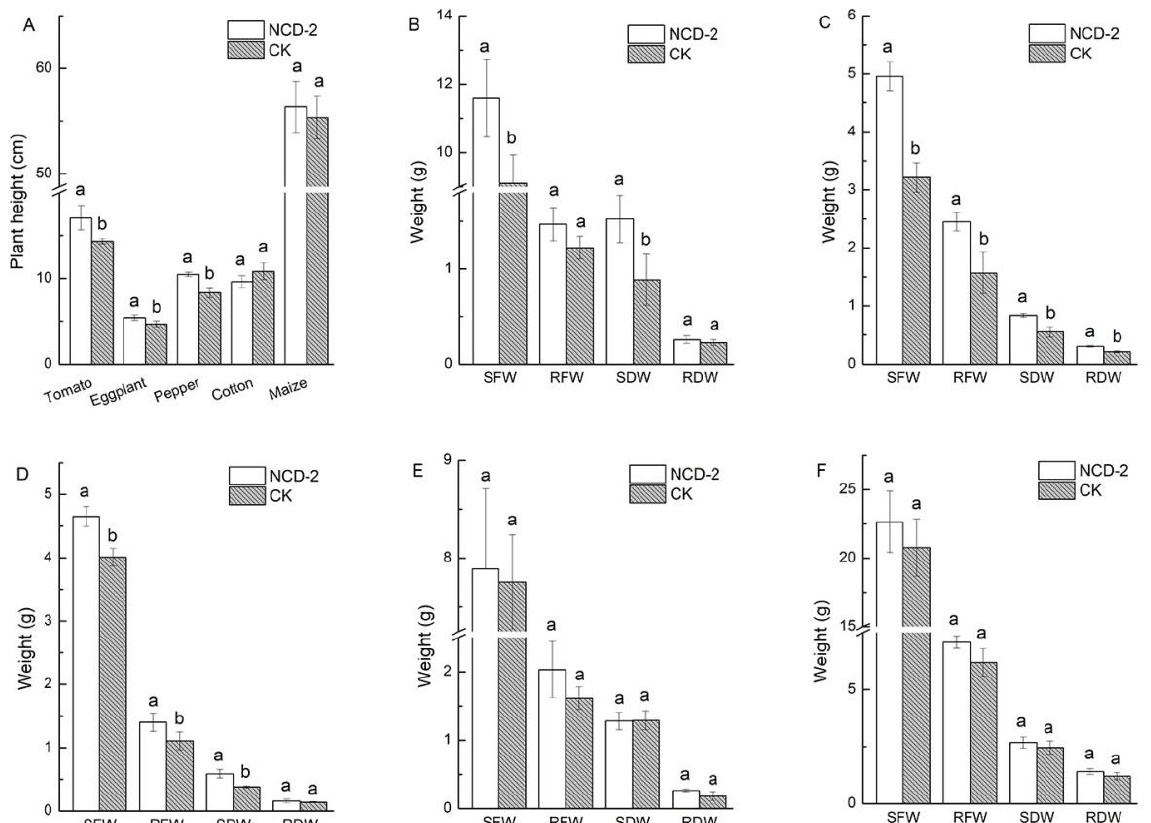
Figure 1. Effect of Bacillus subtilis NCD-2 on the growth indices of different crops. ( A ) Plant height; ( B ) plant fresh and dry weight of tomato; ( C ) plant fresh and dry weight of eggplant; ( D ) plant fresh and dry weight of pepper; ( E ) plant fresh and dry weight of cotton; ( F ) plant fresh and dry weight of maize. SFW represents shoot fresh weight, RFW represents root fresh weight, SDW represents shoot dry weight and RDW represents root dry weight. Each value is the mean of three replicates. Bars with the same lowercase letters indicate no significant difference between treatments based on Student’s t -test ( p < 0.05). NCD-2 represents treatment with B. subtilis NCD-2, CK represents treatment with blank control.